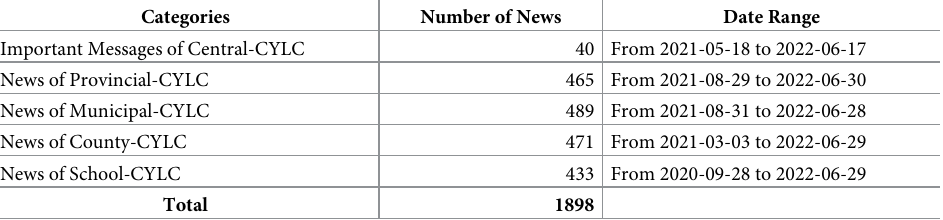
Table 2. Statistics of the numbers of news for each category.